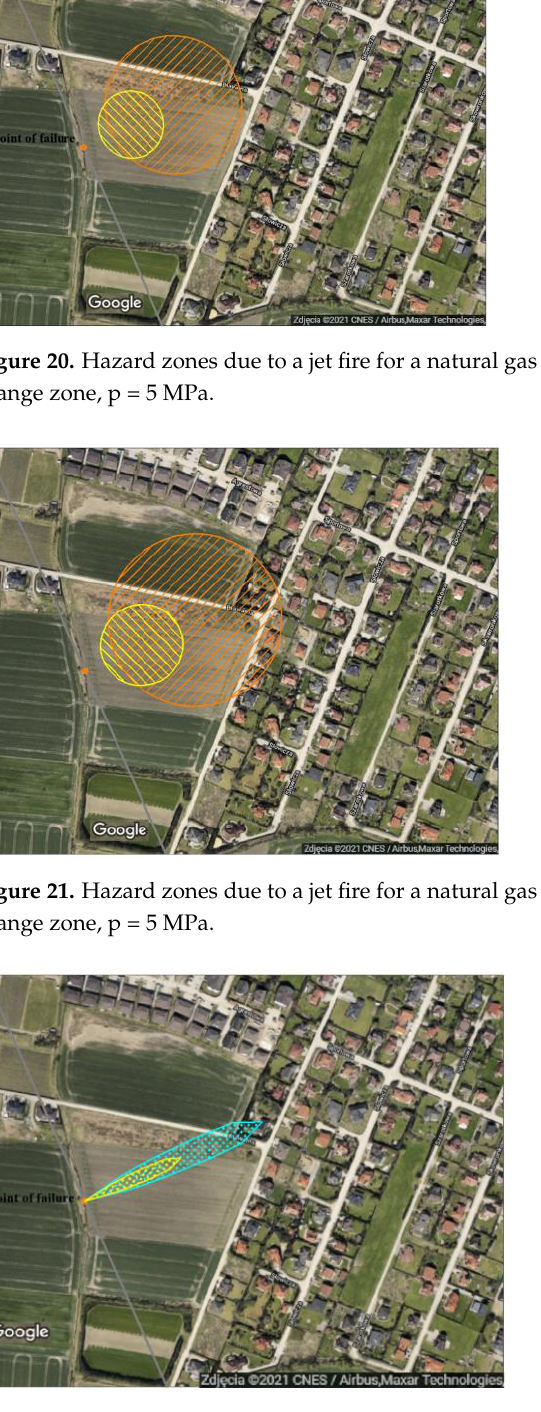
Figure 22. Rang of the natural gas cloud with a concentration above 4.4% (p = 1 MPa) for a = 0.2 (yellow area) and a = 0.5 (turquoise area).